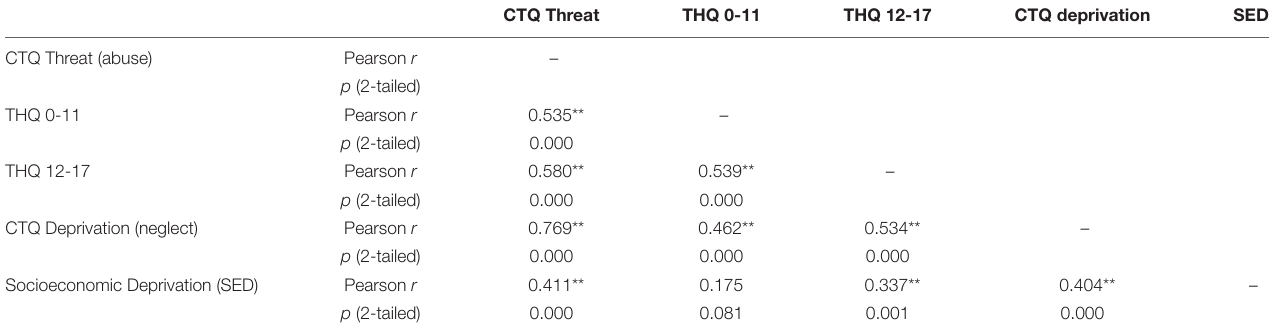
TABLE 1 | Pearson correlations between childhood threat and deprivation measures ( n =